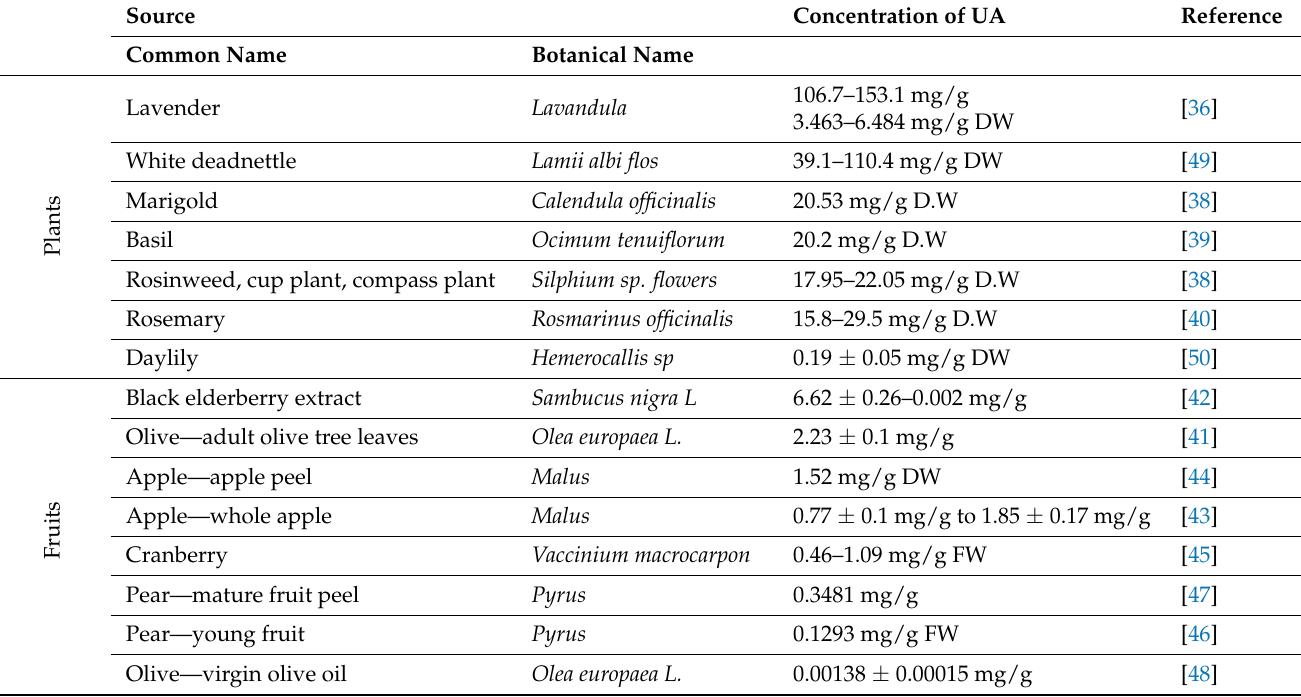
Table 1. Examples of ursolic acid concentrations in plants and